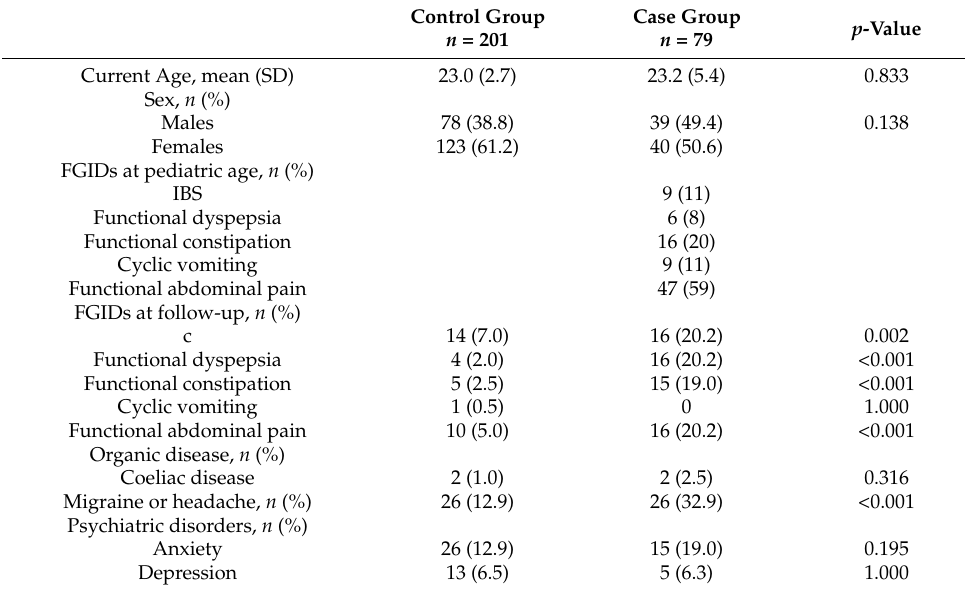
Table 1. Descriptive and comparative table of study and control groups.